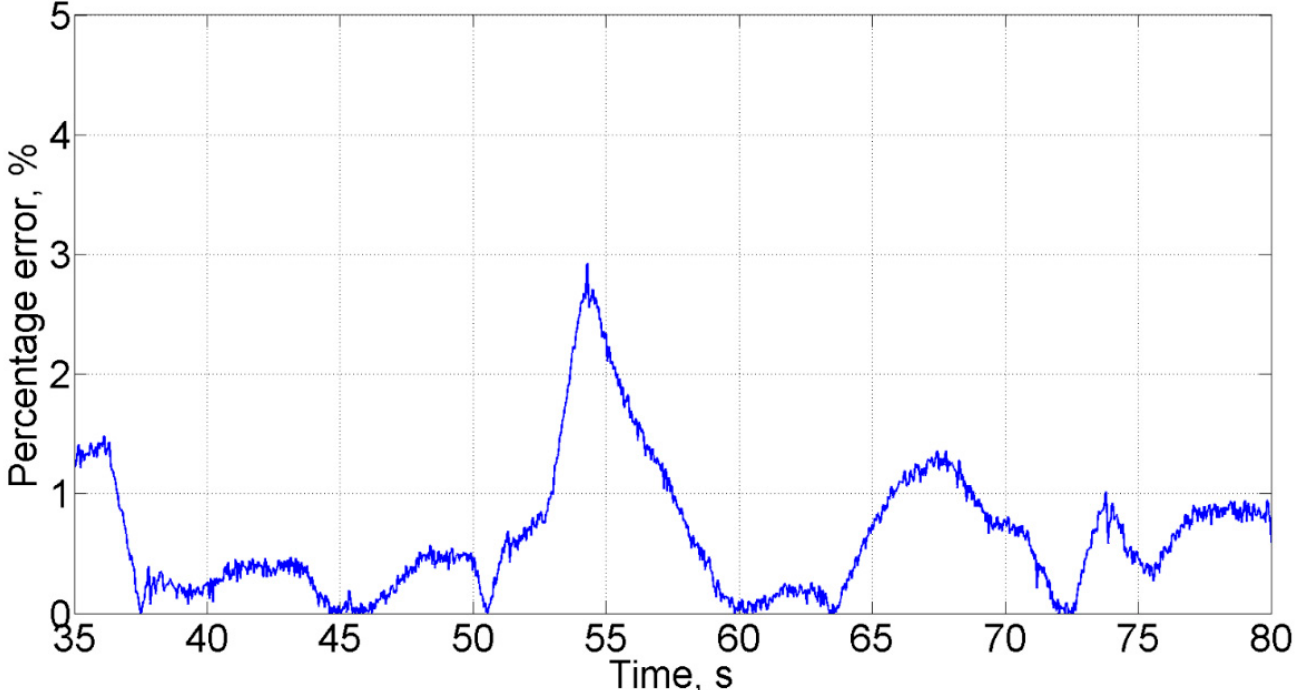
Figure 5. The percentage error between experimental data and simulated results of the pressure in the high-pressure line; the average deviation between the real data and the simulation does not exceed 5%.